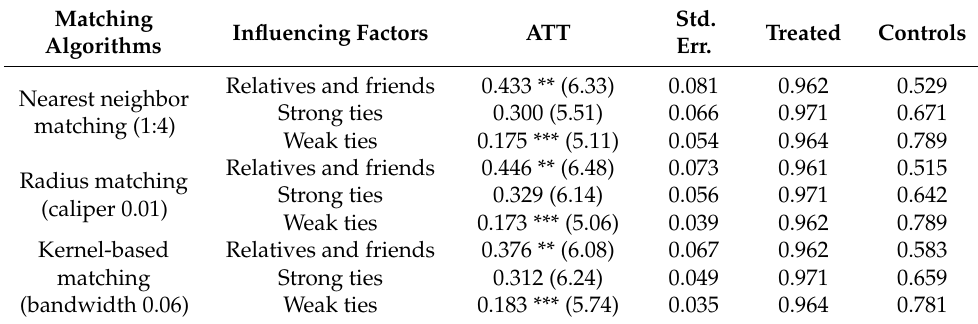
Table 4. Average treatment effects of different matching algorithms.